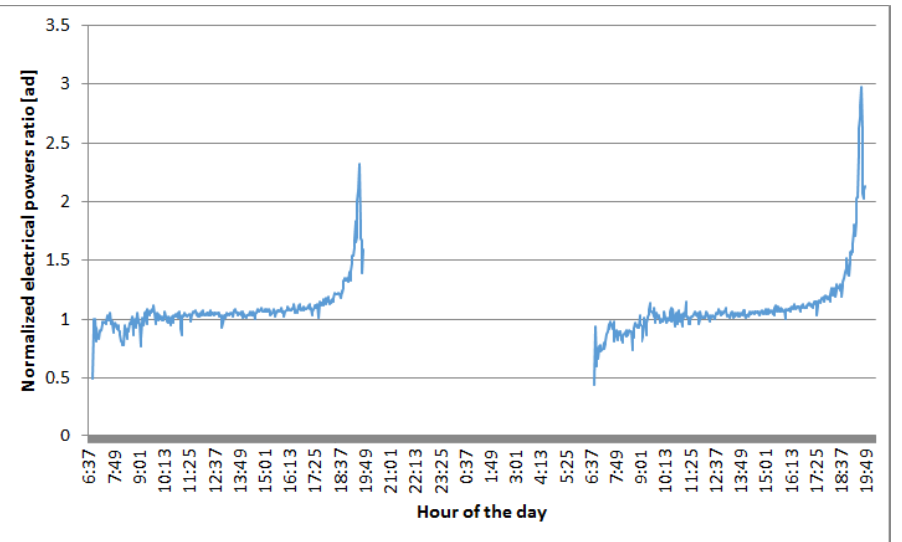
Figure 8. Ratio of the normalized electrical power of the first (coated) array to that of the second (uncoated) array during during two sunny days of the first monitoring